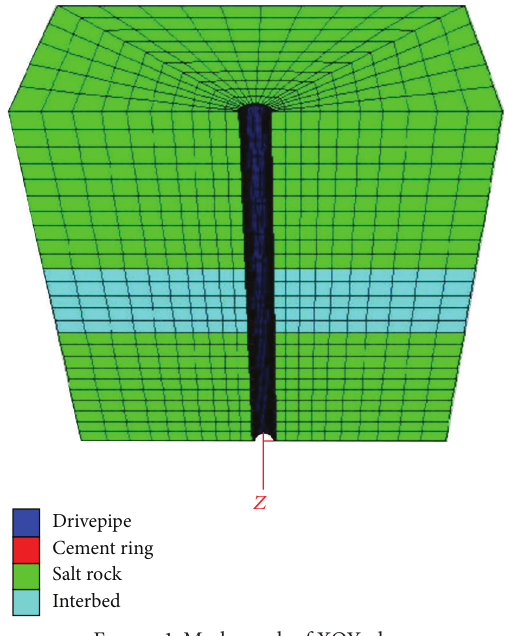
Figure 1: Mesh graph of XOY